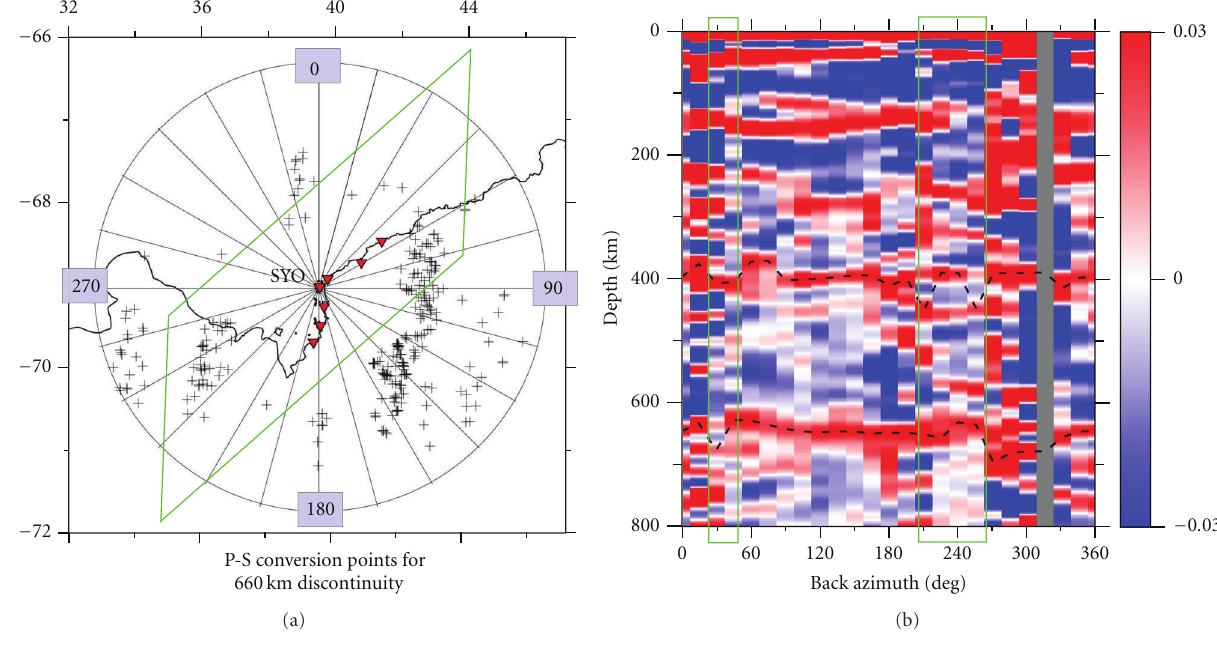
Figure 7: (a) Back azimuth distribution for depth variation in upper mantle discontinuities by receiver function analyses for all GARNET stations. Color images represent the smoothed amplitudes of the receiver functions shown in Figure 6. Two dashed lines are traced for the maximum amplitudes of both 410 km and 660 km depth discontinuities. The two back azimuth groups for strong depth variations in upper mantle discontinuities are circled by the light green open squares. (b) Location of the strong heterogeneous azimuths in LHB. The area for strong depth variations in upper mantle discontinuities is represented by the light green open squares, which are almost parallel with the coastal line. Symbolic notation for the P-S conversion points at the mantle discontinuities are the same as in Figure 5.